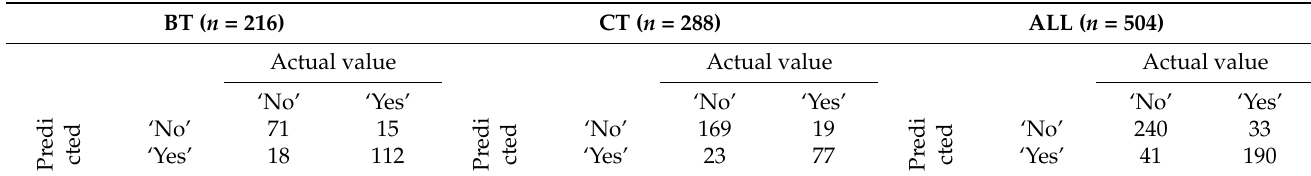
Table 3. Confusion matrix for the selected model characterized by executing SFVS followed by an SVM algorithm with radial kernel and class weights (stepsvmrw) using the BT, CT, and com- plete dataset.